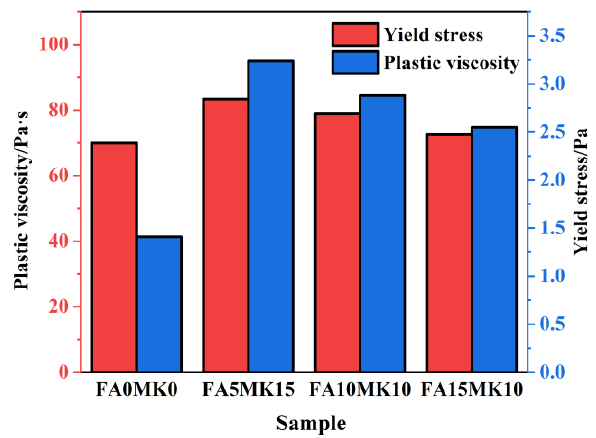
Figure 10. Influence of compound powder on T180 value of MPC.